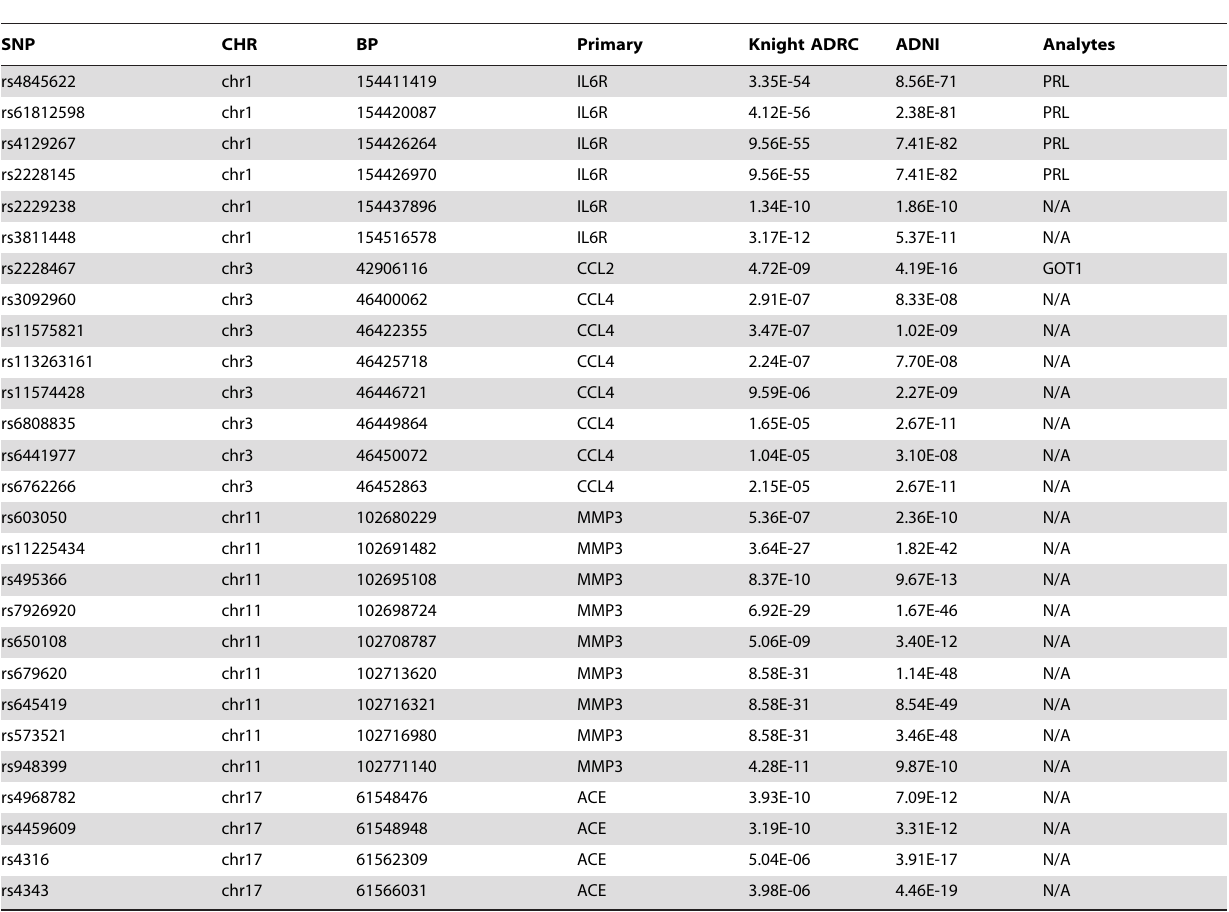
Table 4. Multiphen